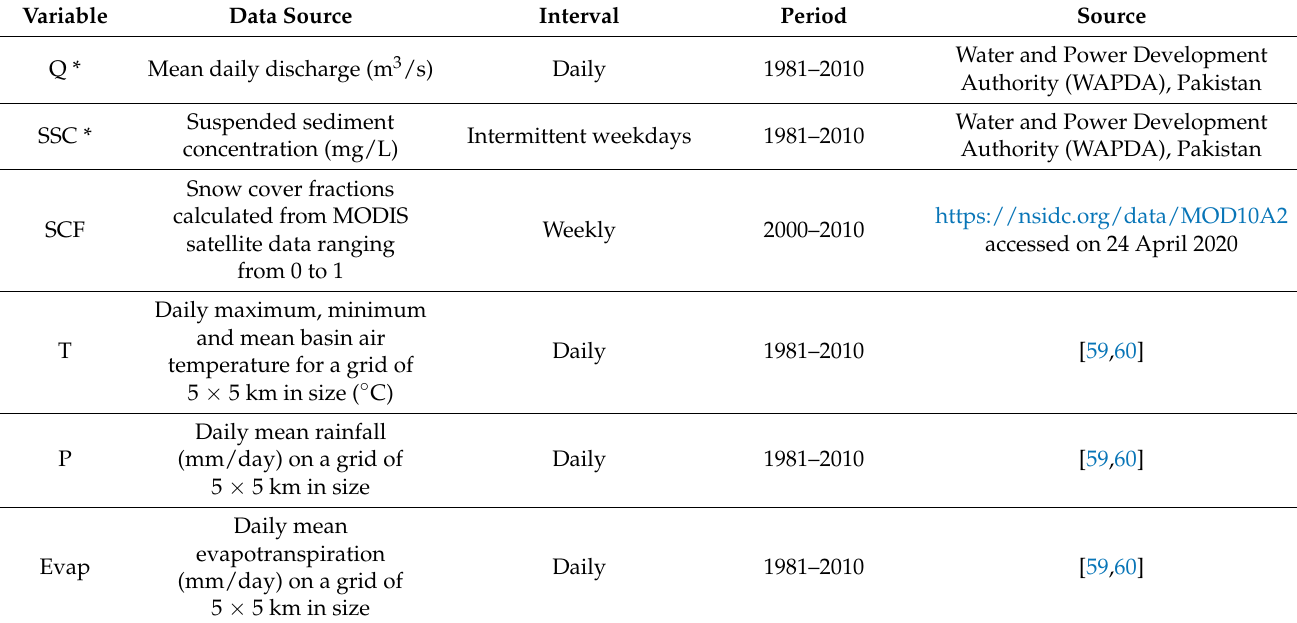
Table 1. Data collected for the prediction of suspended sediment yields for the Gilgit River basin.